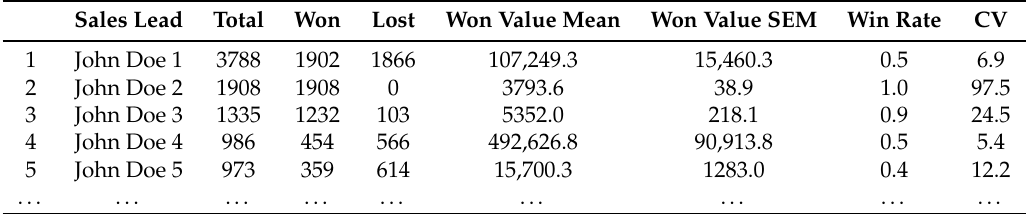
Table 2. Feature Enhancement Lookup Table: An example of the statistics calculated based on “Sales Lead” including counts of the total, won, and lost opportunities along with the mean and standard error of the mean (SEM) for won sales value and their coefficient of variation (CV). Sales Lead Total Won Lost Won Value Mean Won Value